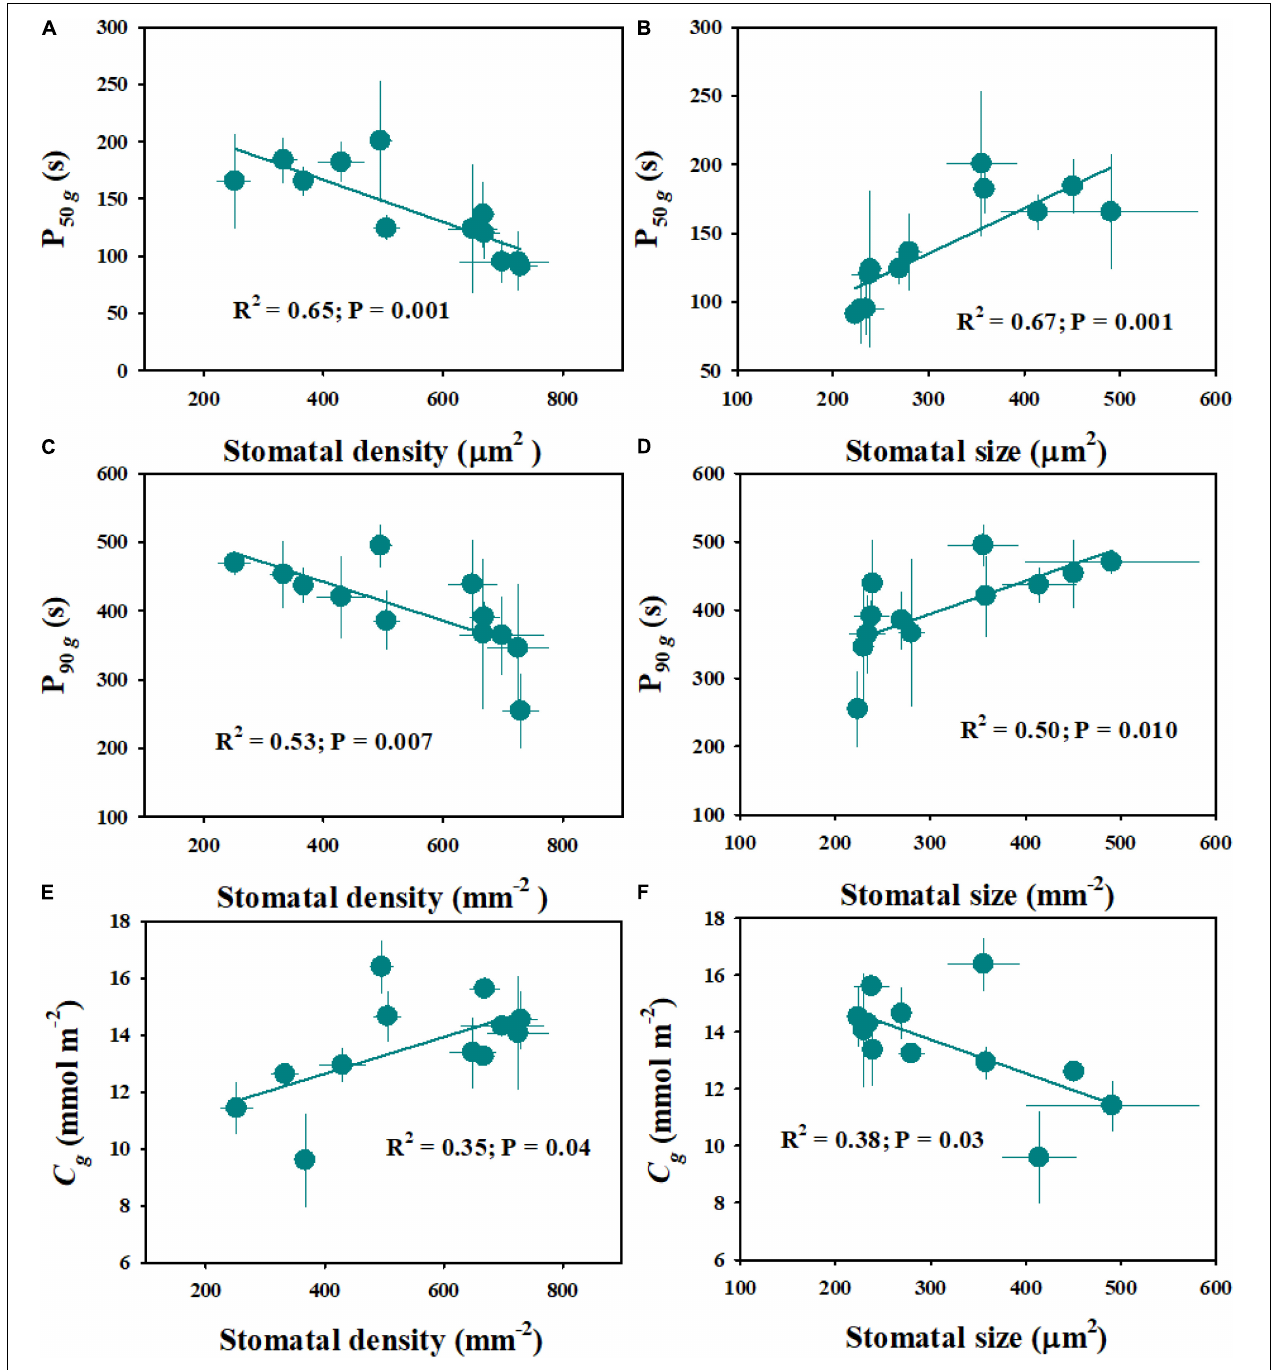
FIGURE 7 | Effect of stomatal morphology (stomatal density and stomatal size) on stomatal kinetics (A–D) and carbon gain (E,F) . Stomatal kinetics (P 50 g , P 90 g ), the time required for g s to reach 50 and 90% of the difference in g si and g sf ; C g , integrated amount of CO 2 uptake. Points and error bars represent the mean ± SD of three